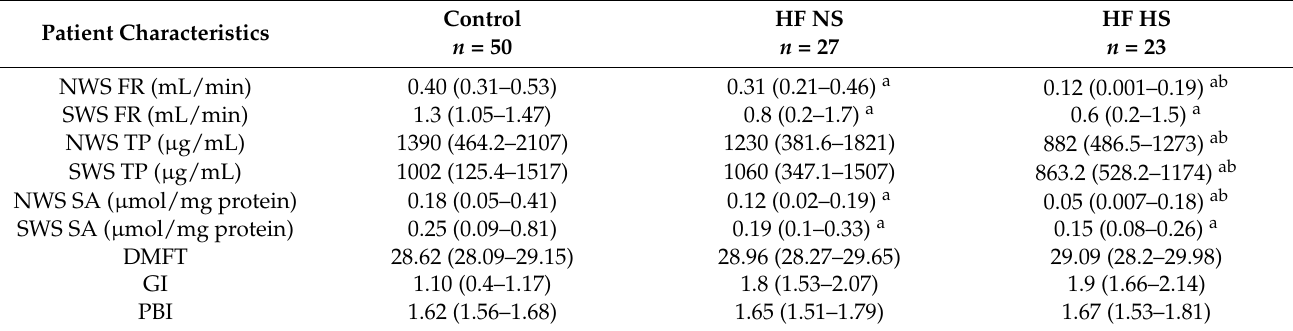
Table 2. Salivary gland function and stomatological characteristics of HF patients and control subjects. Patient